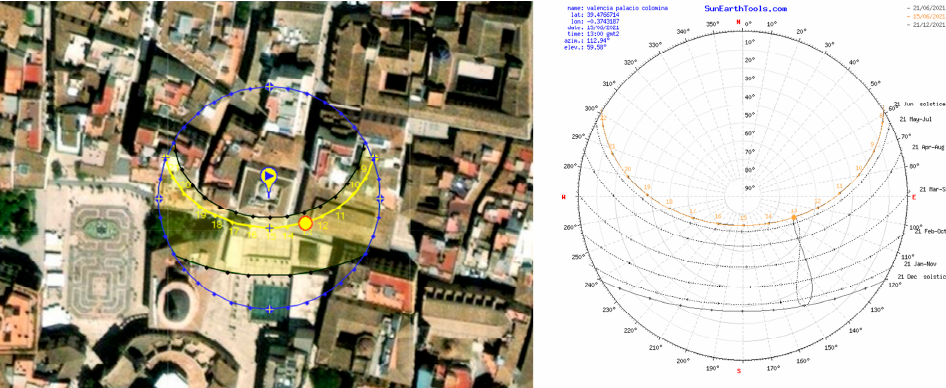
Figure 4. Solar path scheme from one of the days on which the TIR images were collected.